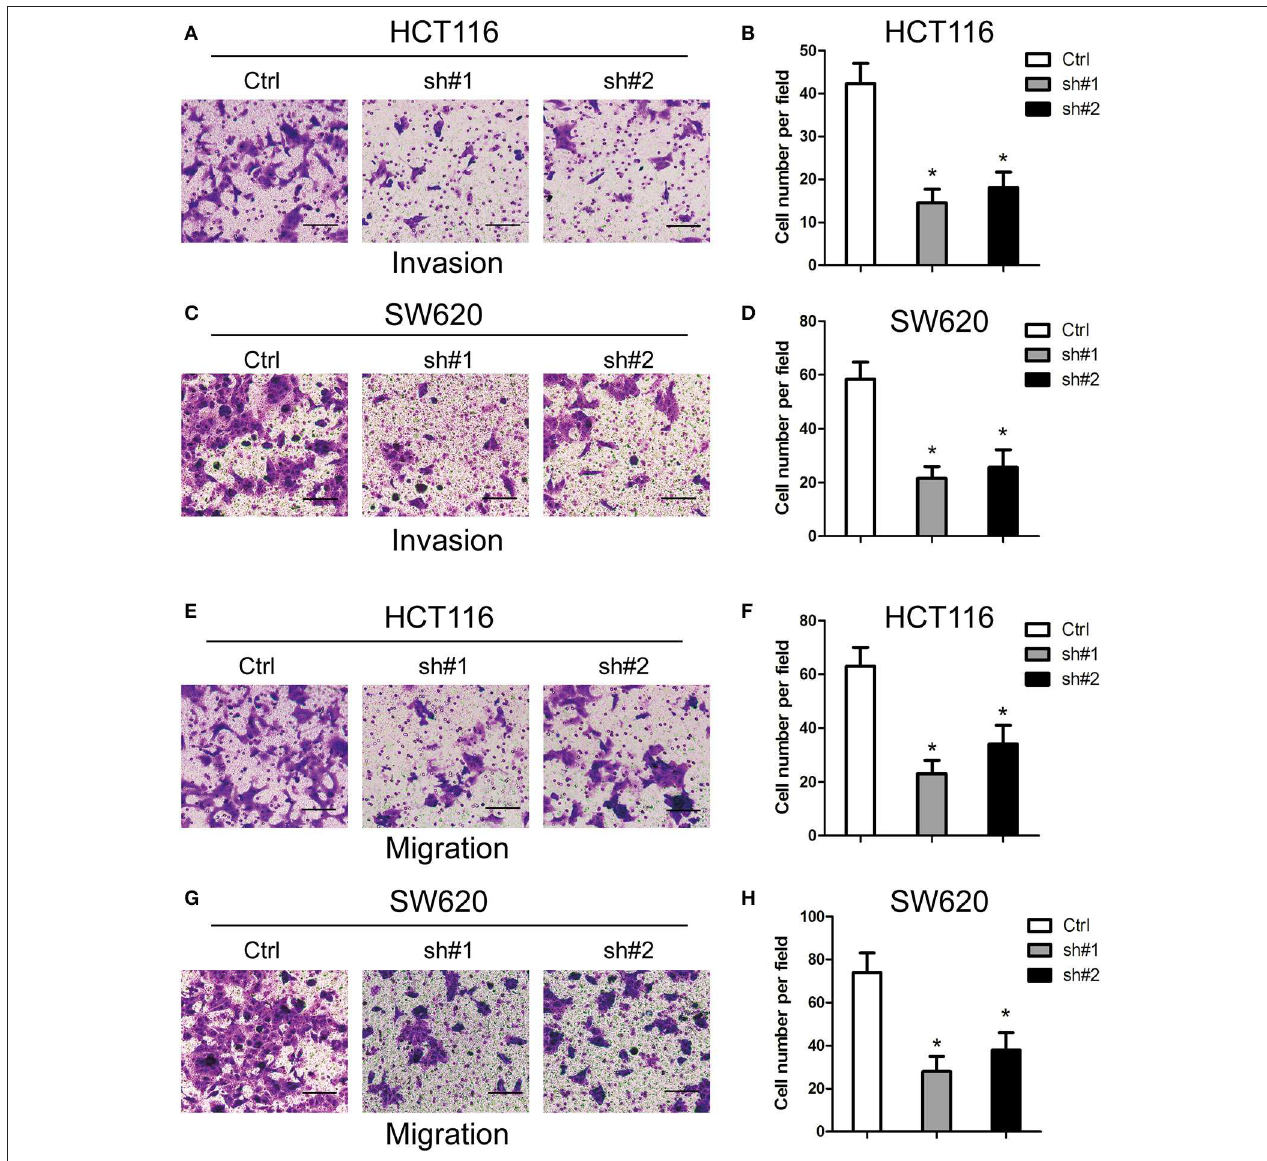
FIGURE 3 | Effects of MIR4435-2HG on colorectal cancer (CRC) cells’ invading and migrating processes in vitro . (A–D) Invasive potential of MIR4435-2HG knockdown in HCT116 and SW620 cells compared with that in their respective controls was analyzed using a Transwell invasion assay. * P < 0.05; n = 3. (E–H) Migratory potential of MIR4435-2HG knockdown in HCT116 and SW620 cells compared with their respective controls analyzed using a Transwell migration assay. * P < 0.05; n =